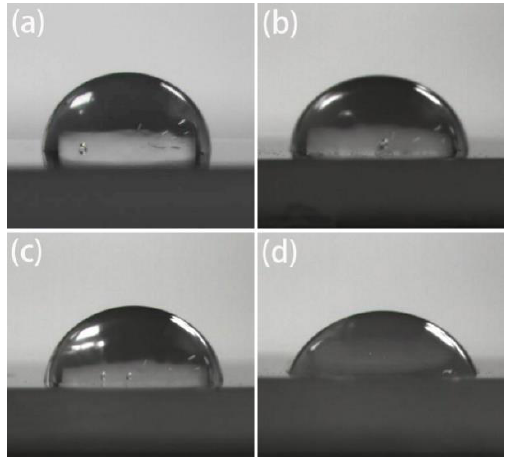
Figure 9. Contact angles of iPB-1 and iPB-g-MAH samples with different Gd: ( a ) iPB-1; ( b ) Gd = 1.09%; ( c ) Gd = 2.74%; ( d ) Gd = 4.1%.